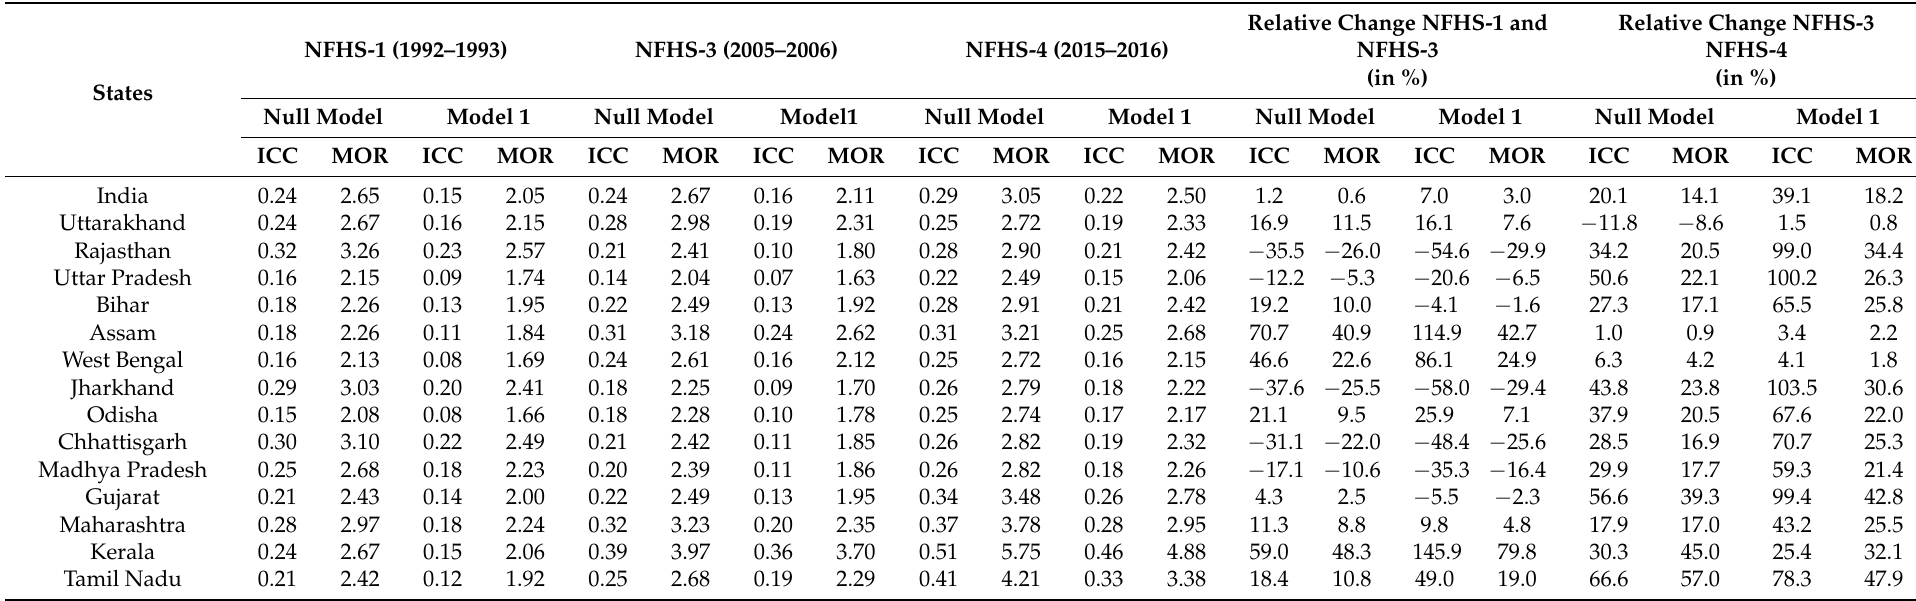
Table 5. Intra-class correlation (ICC) and median odds ratio (MOR) and their relative change for India and selected states, 1992–2016.